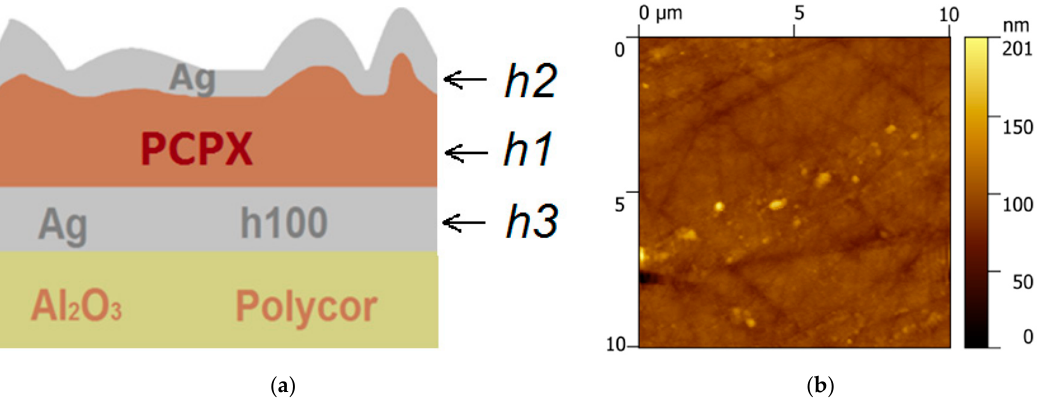
Figure 1. SERS structure based on sanswich Ag–PCPX–Ag: ( a ) Ag–PCPX–Ag structure schematic; ( b ) AFM image of polycore.